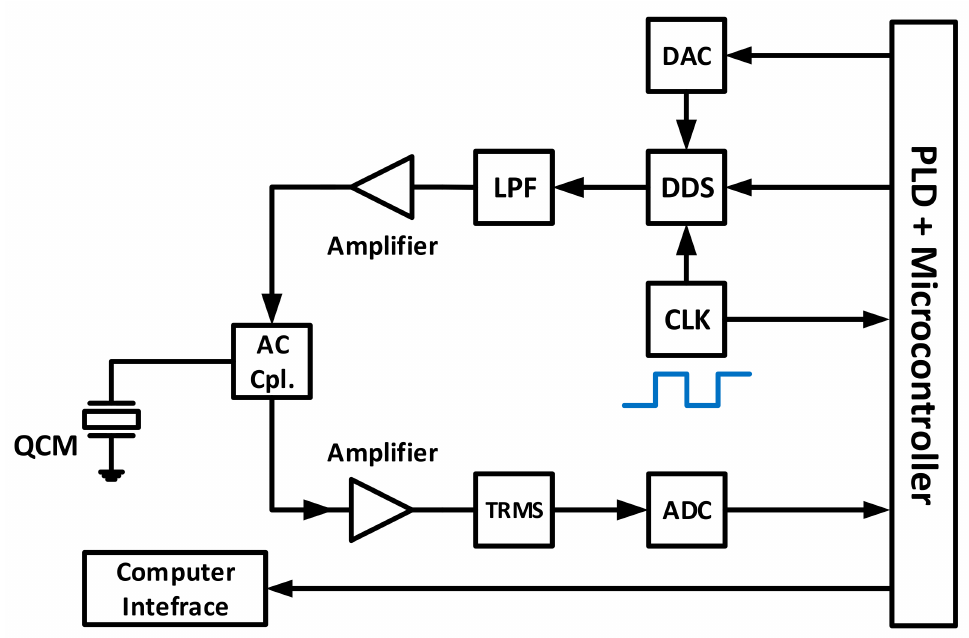
Figure 12. Rapid impedance measurement compact system from [72], based on DDS and PLD